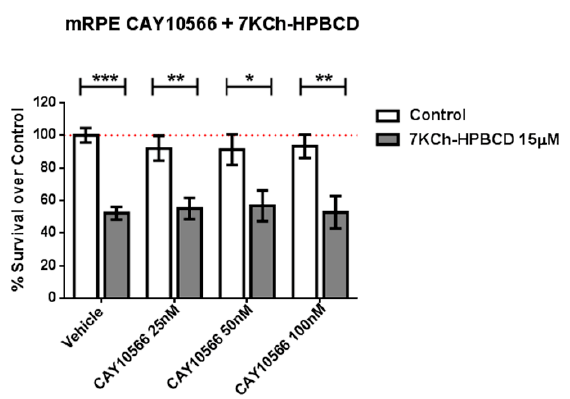
Figure 3. SCD1-inhibitor CAY10566 does not protect against the 7KCh-induced cell death in mRPE cells. Different CAY10566 doses were tested to restore cell viability against the 15 µM 7KCh-HPBCD cytotoxicity. Data represented mean ± SEM of 12-well plates of at least four different experiments. * p < 0.05, ** p < 0.01, *** p < 0.001. The red dashed line is a guidance mark of 100% of viability of control cells treated with vehicle only. White bars correspond to cells treated only with CAY10556 (0–100 nM), while grey bars correspond to cells treated with 7KCh-HPBCD 15 µM and CAY10556 (0–100 nM).